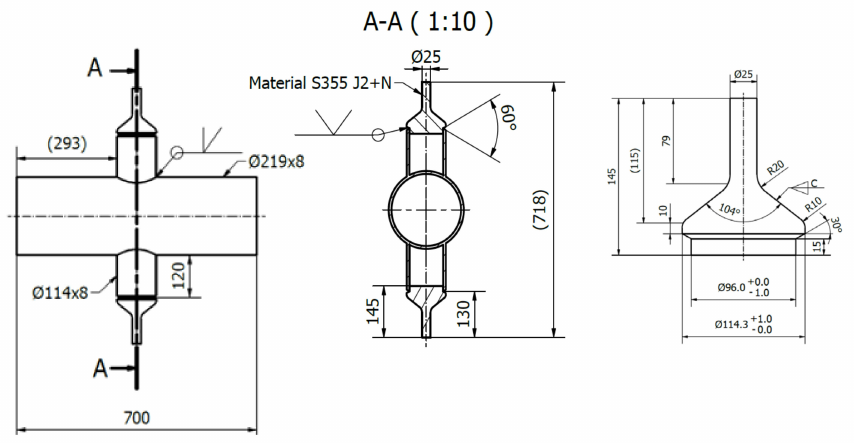
Figure 5. DT Joint geometry (all units are in